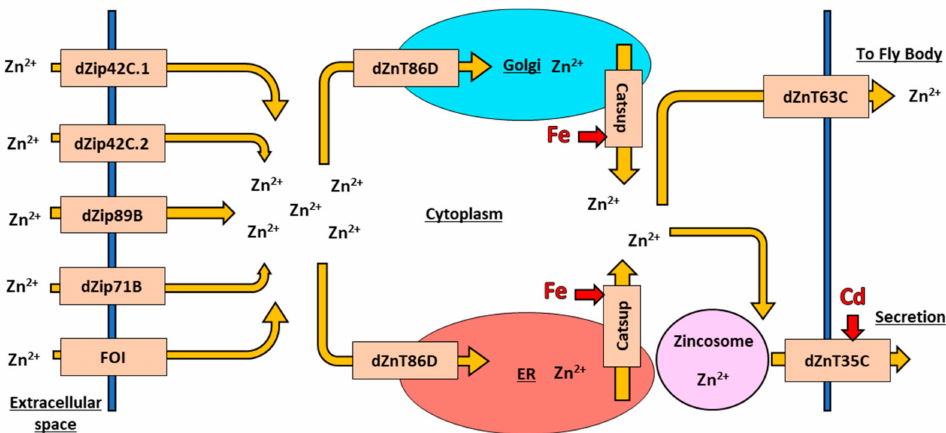
Figure 3. A diagram of the D. melanogaster Zn transport system transporting Zn and interactions with other metals. In addition to the pattern and colour schemes from Figures 1 and 2, the endoplasmic reticulum is coloured blood orange, and extracellular transporters are coloured pink. Underlined labels denote areas inside the cell, organelles, or space outside of the